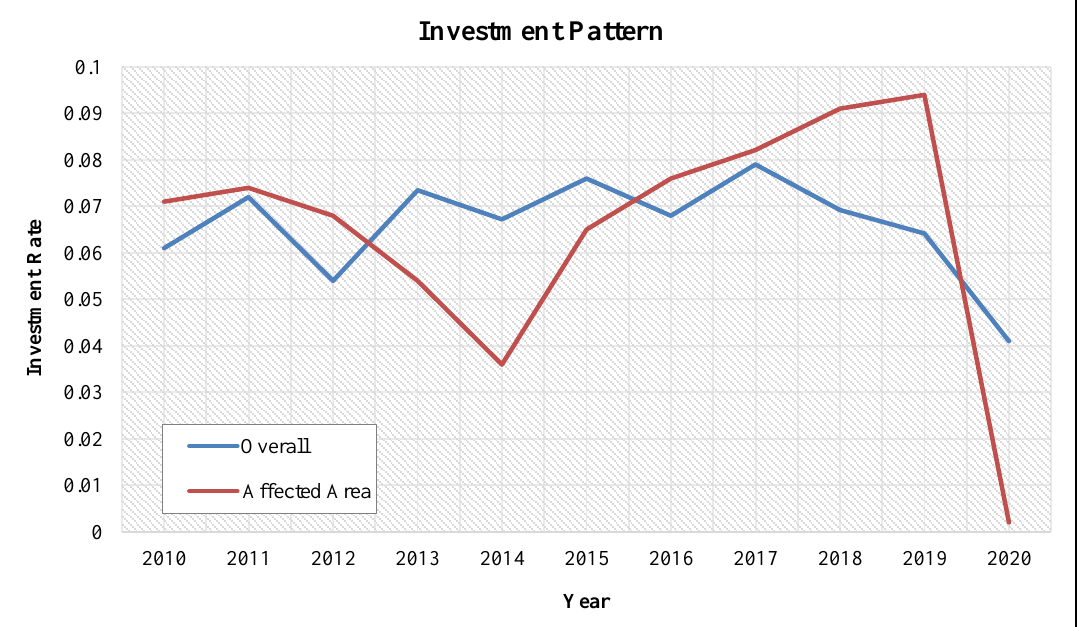
Figure 3. Average Investment